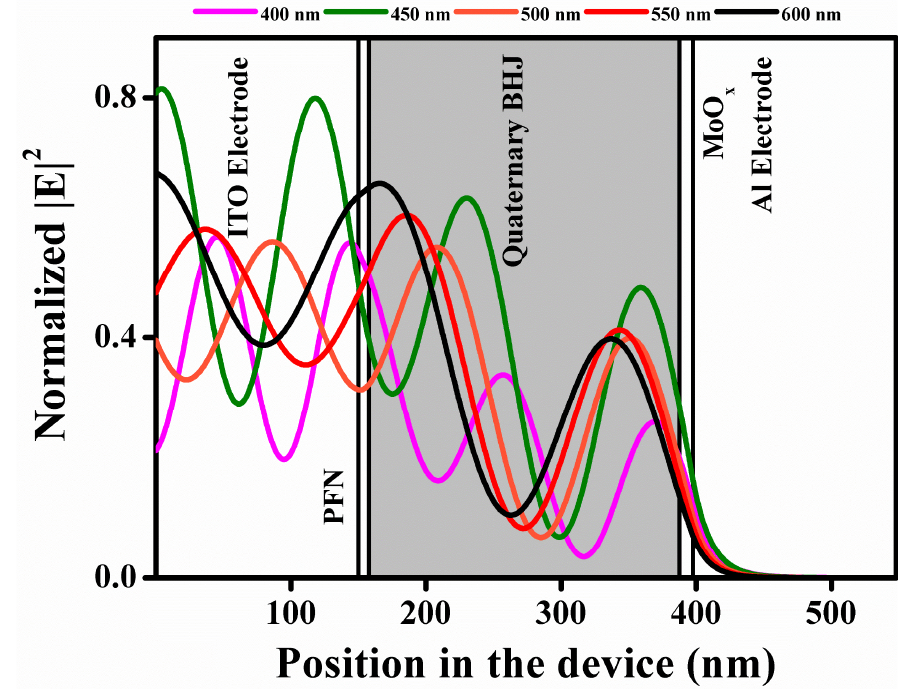
Figure 3. Electric field intensity distribution inside the photovoltaic structure obtained through a finite-difference time-domain (FDTD) simulation. The thickness of the active layer was 230 nm, which showed peak absorption under 500 lx indoor white LED illumination.